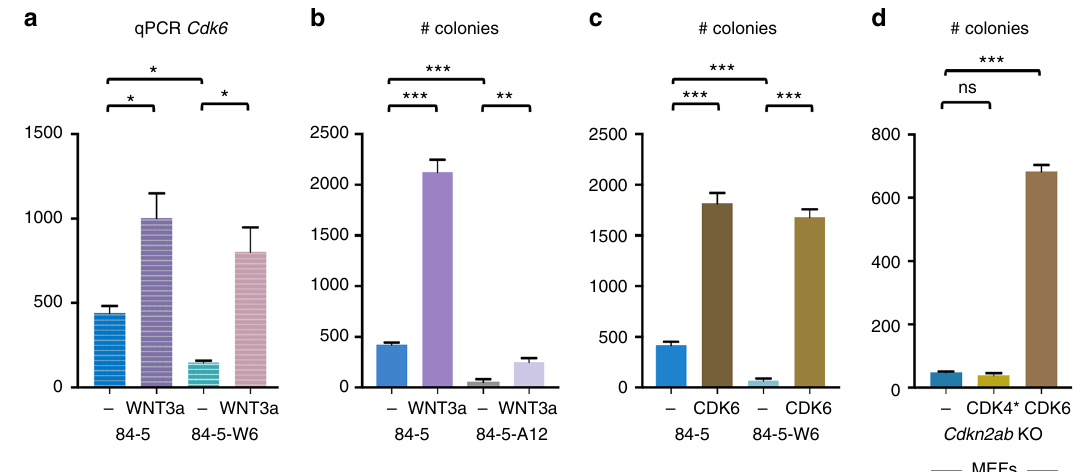
Fig. 7 Validation of functional involvement of CDK6 in WNT induced transformation of MEFs and skin tumour cell lines. a mRNA analyses (qPCR) of Cdk6 relative to Gapdh of 84-5 tumour cells and of 84-5-W6 tumour cells knockout for Wnt7b with and without WNT3a supplementation. b Anchorage- independent colony formation of tumour cell lines 84-5 and 84-5-A12 ( Cdk6 knockout derivative) with and without WNT3a supplementation. c Anchorage- independent colony formation of tumour cell lines 84-5 and 84-5-W6 ( Wnt7b knockout derivative) with and without overexpression of retrovirally transduced Cd k6. d Anchorage-independent colony formation of Cdkn2ab − / − MEFs with and without overexpression of retrovirally transduced Cdk6 and CDK4-R24C (CDK4*). Statistical analysis (Unpaired t test): ns: not signi fi cant, * p < 0.05, ** p < 0.01, *** p < 0.001. Error bars represent Standard Deviation of the Mean (3 replicates) ( a ) or Standard Error of the mean (3 replicates) ( b – d ). Cdkn2ab knockout mice develop skin tumours but this phenotype is lost on backcrossing of the mice. Here, the authors describe a genetic variant encompassing Wnt7b that synergises with Cdkn2ab loss and is required for tumour formation in these